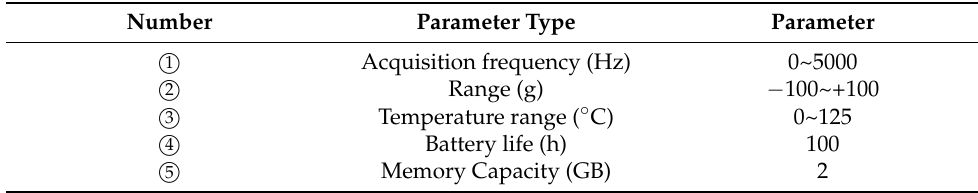
Table 2. Specific parameters of measuring equipment sensor.